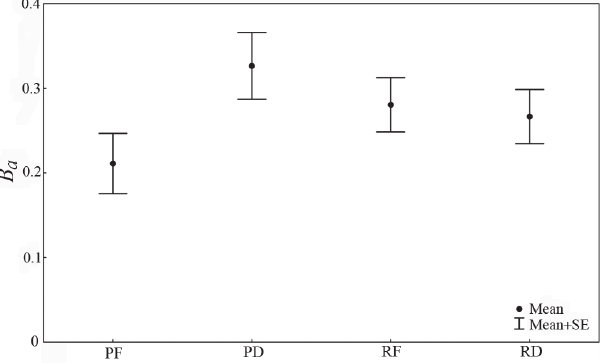
Fig. 6. Median+quartile 75% of the Pianka’s symmetric index among all fish species pars, in each spatial- temporal units in the Cuiabá River basin, Mato Grosso State, Brazil. PF = Pond Flood; PD= Pond Drought; RF= River Flood; RD= River